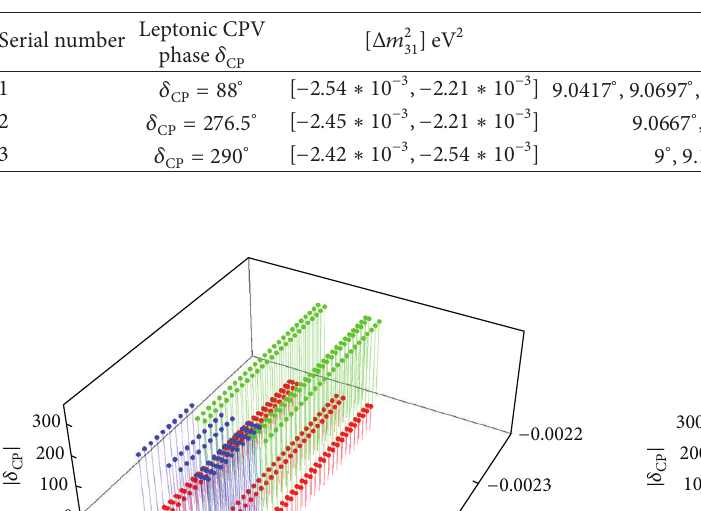
Table 1: The summary of our calculated values of 𝛿 CP , 𝜃 13 , and Δ𝑚 2 31 in case of IH and LO for 𝑅 1𝑗 elements of 𝑅 matrix comprising 𝑈 PMNS and 𝑉 CKM .